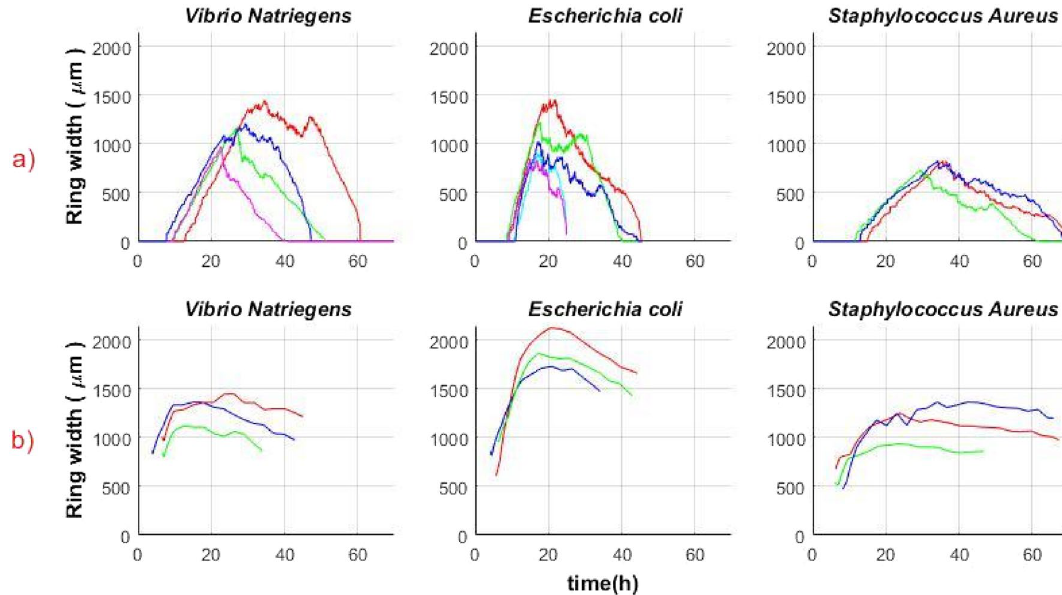
Figure 10. The width of activity “ring” as a function of time for different bacterial colonies; ( a ) width of activity “ring” determined by the speckle method; ( b ) calculated “ring” width using the Pirt model (Eq. 9). Parameters: alpha and r for the model are also obtained from speckle experiments. Each curve demonstrates the width of the activity “ring” over time of the one colony of a specific bacteria